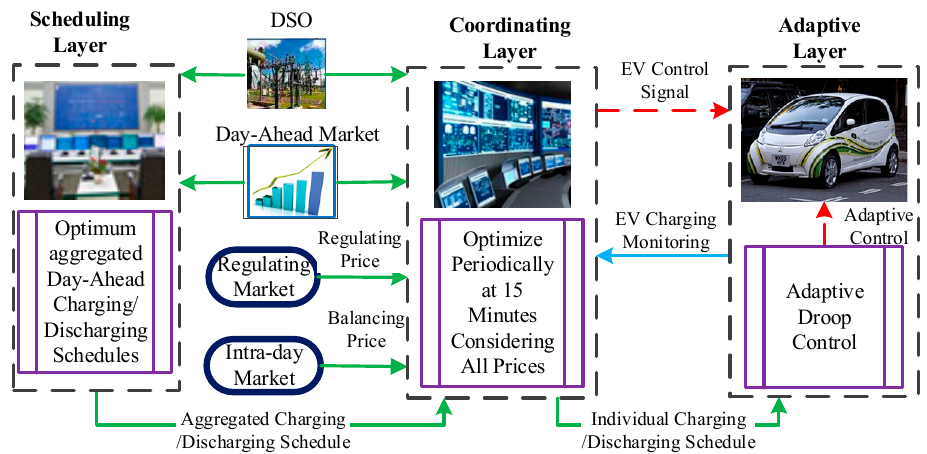
Figure 5. Hierarchical coordinated schematic.